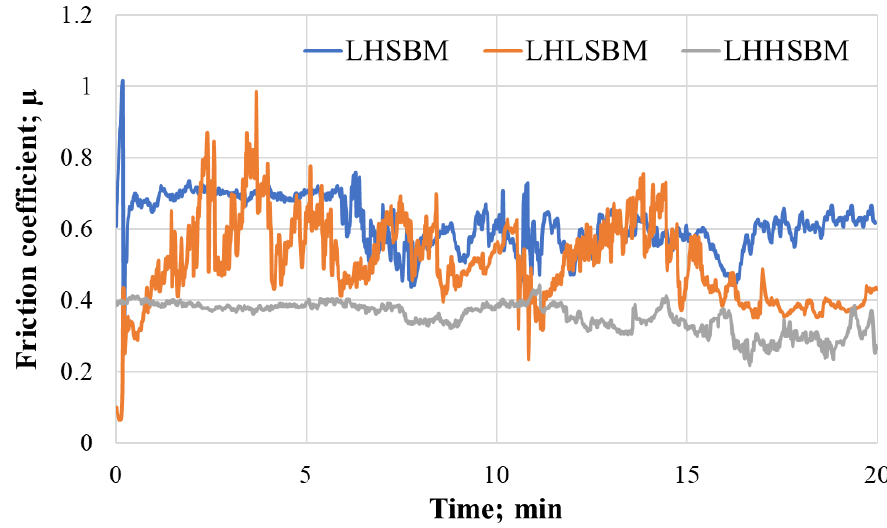
Figure 15. The real-time friction coefficient of Al/SiC composites under 10 N load.